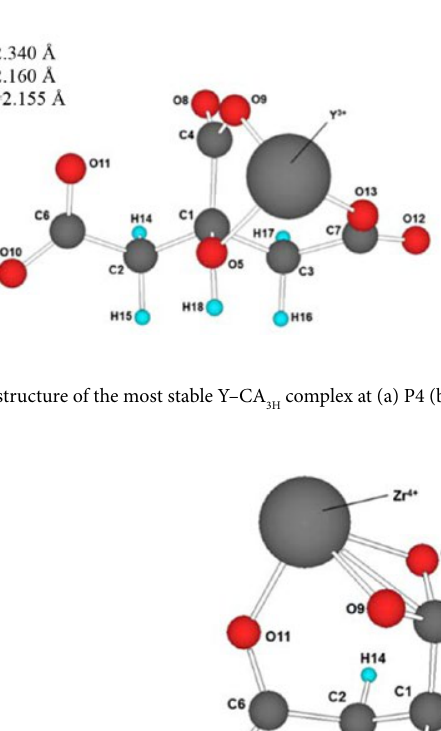
Fig. 3. Optimized structure of the most stable Ba–CA (P2)